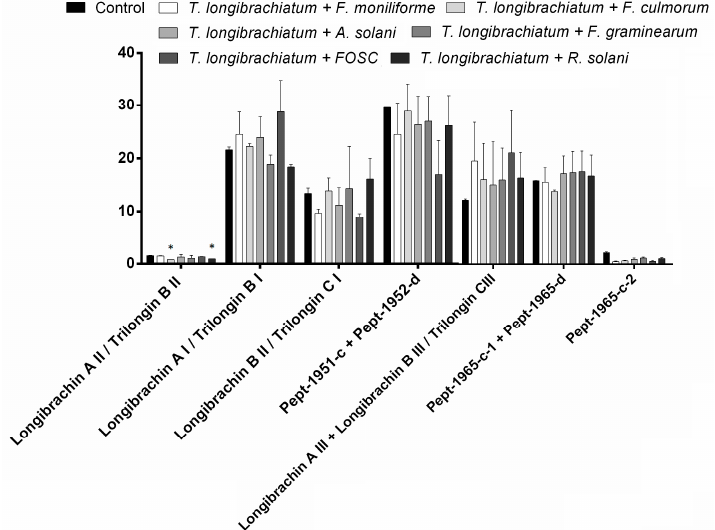
Figure 8. Relative amounts of peptaibols identified from Trichoderma longibrachiatum IRAN 3067C in interaction with plant pathogens compared with the control ( Trichoderma without plant pathogens) in confrontation tests. Asterisks indicate significant differences, as determined by Student’s t test (* p < 0.05) corrected with the Holm–Šidak method.